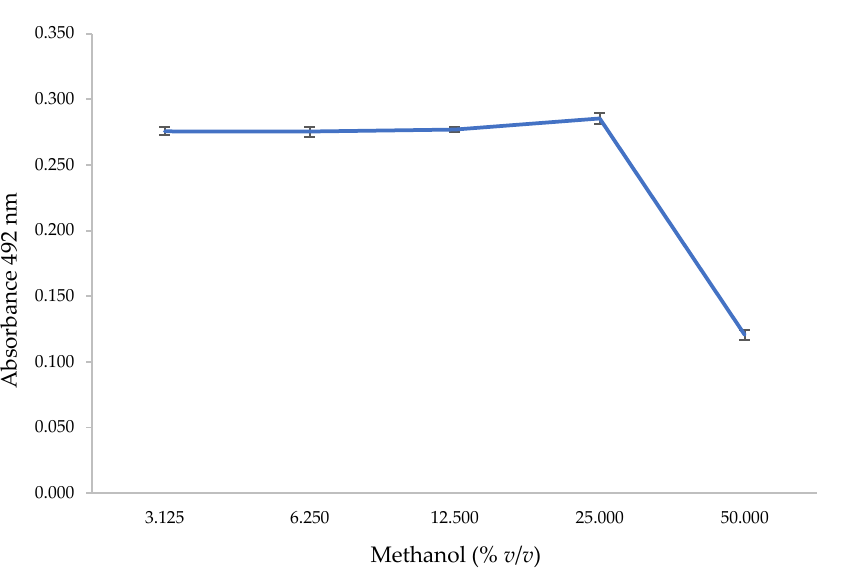
Figure 6. Effect of different percent methanol on the antibody activity of immunoassay ( n = 3), methanol in 1% skim milk. Table 3. Percentage of recovery (%R) of the different concentrations of enrofloxacin evaluated in buffer and in matrices, mean recoveries and the coefficient of variation (CV) in meat-extracted matrices.